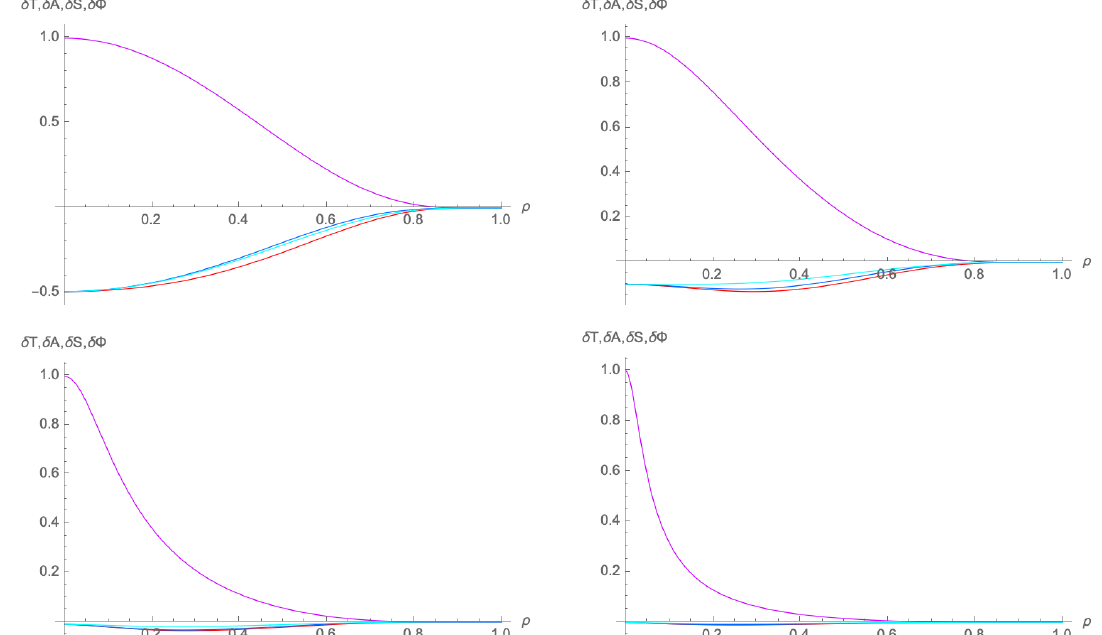
Figure 4 . Figure showing the most unstable mode wavefunctions for flow of perturbations of electrically charged RN for charges r − = 1 / 2 (top left), r − = 0 . 9 (top right), r − = 0 . 99 (bottom left) and r − = 0 . 999 (bottom right). The wavefunction δT is shown in red, δA in blue, δS in purple, and the potential perturbation δ Φ is in light blue. The modes are normalized to have δS = 1 at the horizon, and we see δS dominates the near horizon behaviour as extremality is approached, and becomes increasingly localized